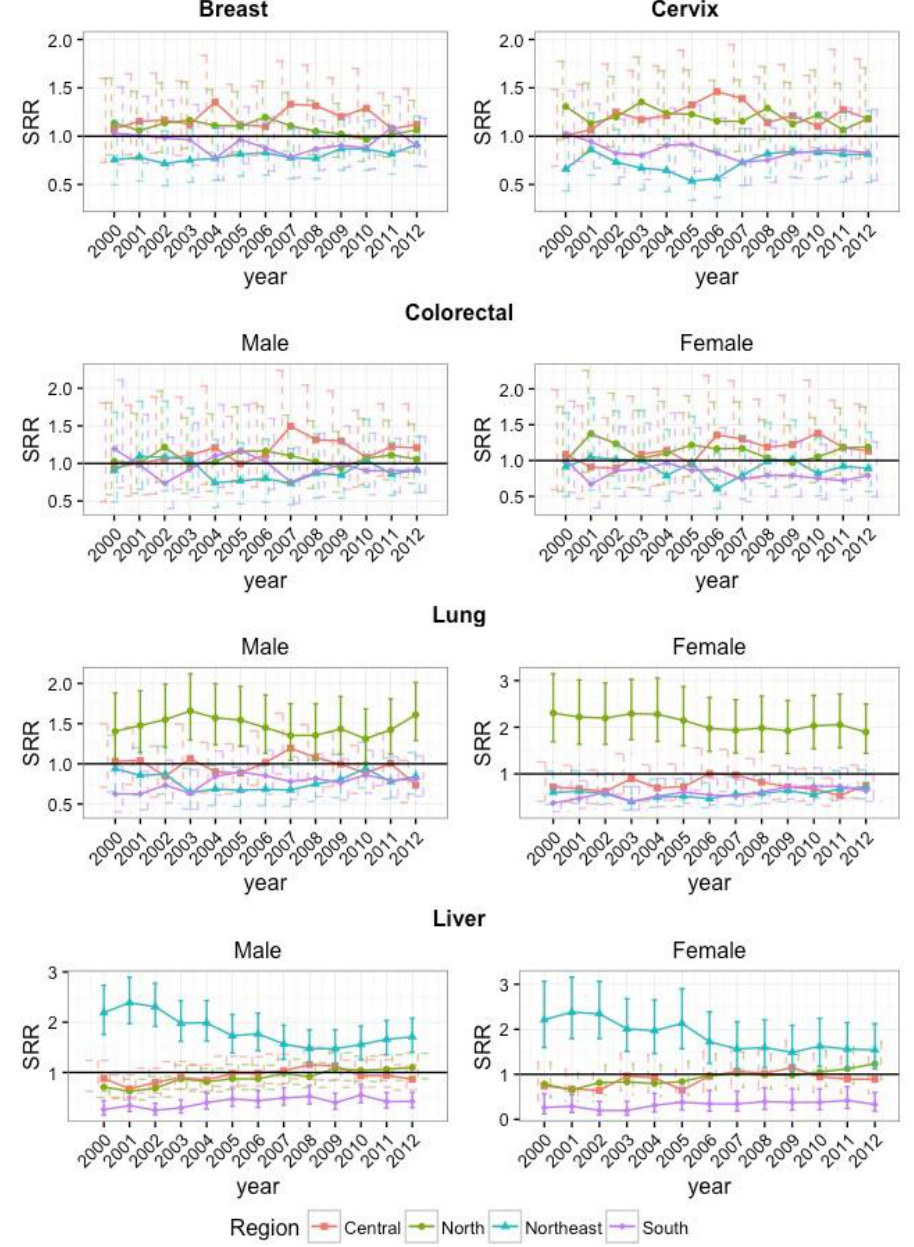
Figure 6. Standardized rate ratios (SRRs) and their 95% confidence intervals comparing incidence of each region to national estimates (SRR = 1) from 2000 to 2012. Solid lines for confidence intervals indicate significant SRRs and were only highlighted if SRRs were significant for all years. Significance was achieved at α = 0.05.